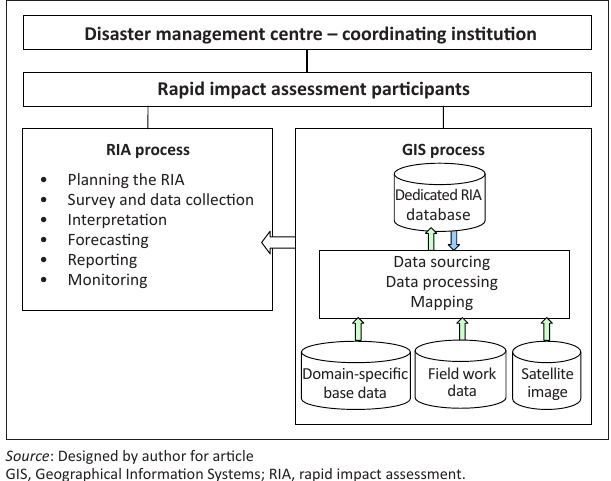
FIGURE 3: Integration of Geographical Information Systems with the rapid impact assessment